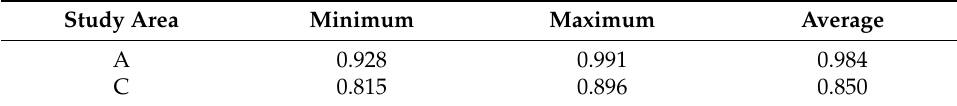
Table 3. Stress factor ( f ) within each study area.